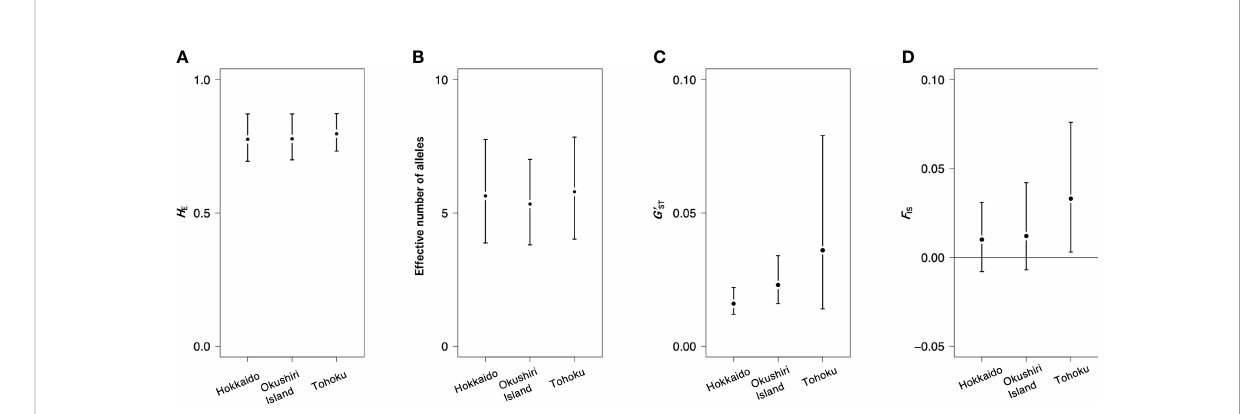
When K = 3 (Figure 5B), the F values were 0.0125, 0.0122 and 0.0141 for Cluster I, II, and III, respectively. Three different clusters dominated the three different regions; that is, Custer I, II, and III for Tohoku, Hokkaido, and Okushiri Island, respectively. Unrooted neighbor-joining cladograms among the 3 clusters based on F ST genetic distance matrix showed a